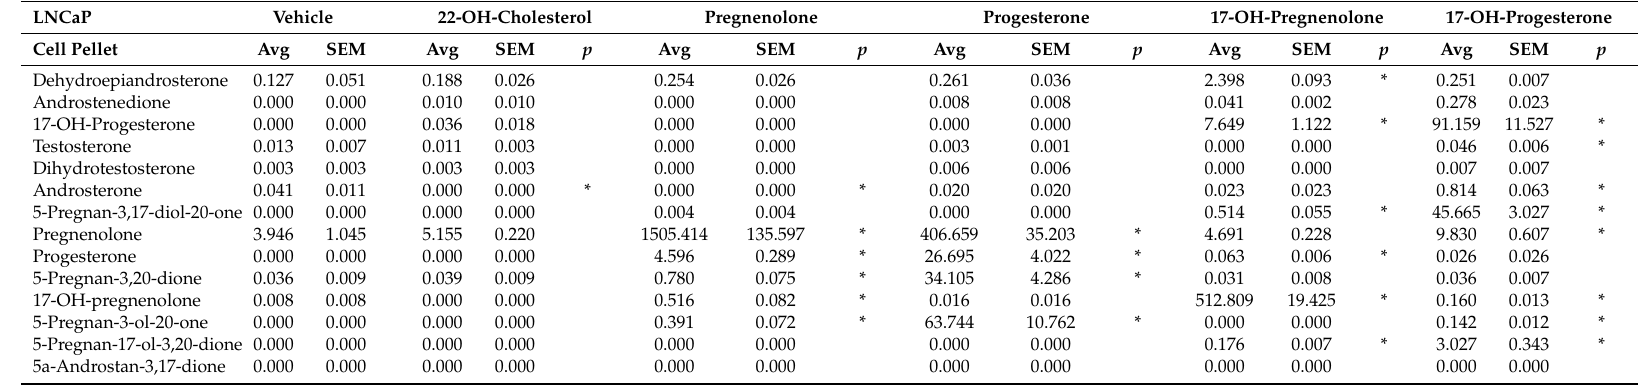
Table 2. Steroid levels (ng/mL) detected in LNCaP cells after 48 h of incubation with 2 µ g/mL of 22-OH-cholesterol, pregnenolone, progesterone, 17-OH-pregnenolone, 17-OH-progesterone, or vehicle. * Statistically significant ( p < 0.05) when compared to the vehicle control. Mean ± standard error of the mean (SEM) values were obtained from three separate experiments performed on different